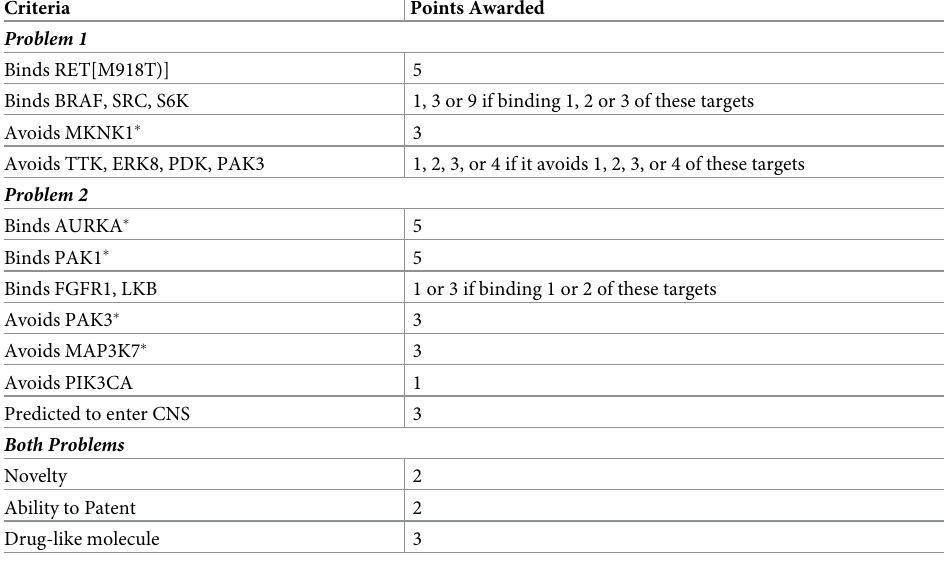
Table 1. Scoring guidelines for Problems 1 and 2. Starred targets indicate that binding or avoiding that target was a requirement to receive target-based points. Criteria Points